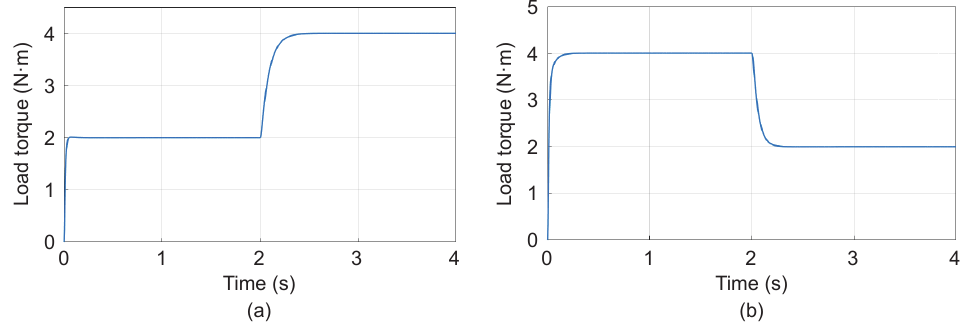
Fig. 12 Load torque identification results. (a) Identification results of load surging from 2 N·m to 4 N·m. (b) Identification results of load dropping from 4 N·m 2 N·m.